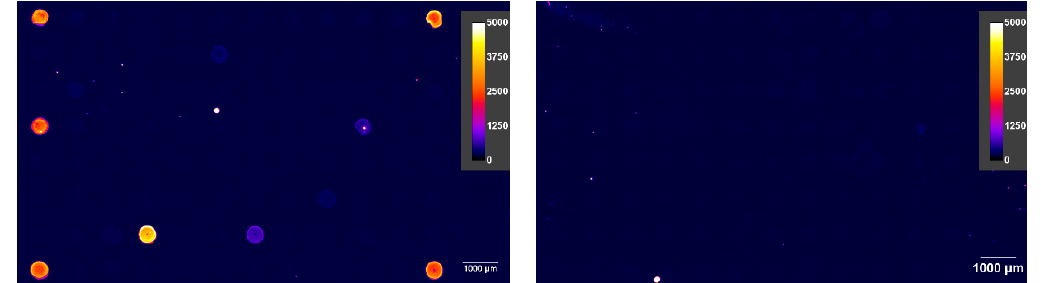
Figure 10. Non-competitive mAb incubation ( left ) and the competitive incubation with 27 mg L − 1 carbamazepine (CBZ) ( right ). The positive spots are strongly inhibited by the hapten (analyte), which means that the respective antibodies bind selectively to the target compound, CBZ.